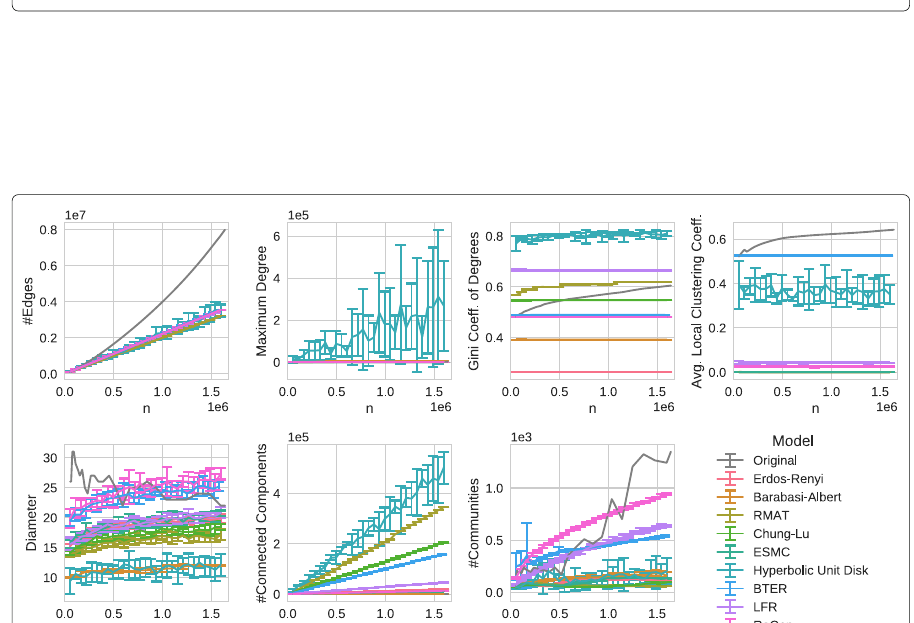
Fig. 12 Structure replication of the diverse set of networks (Table 2) with scaling factor 4. a Relative deviation of scalar network properties. b Distribution of centrality scores